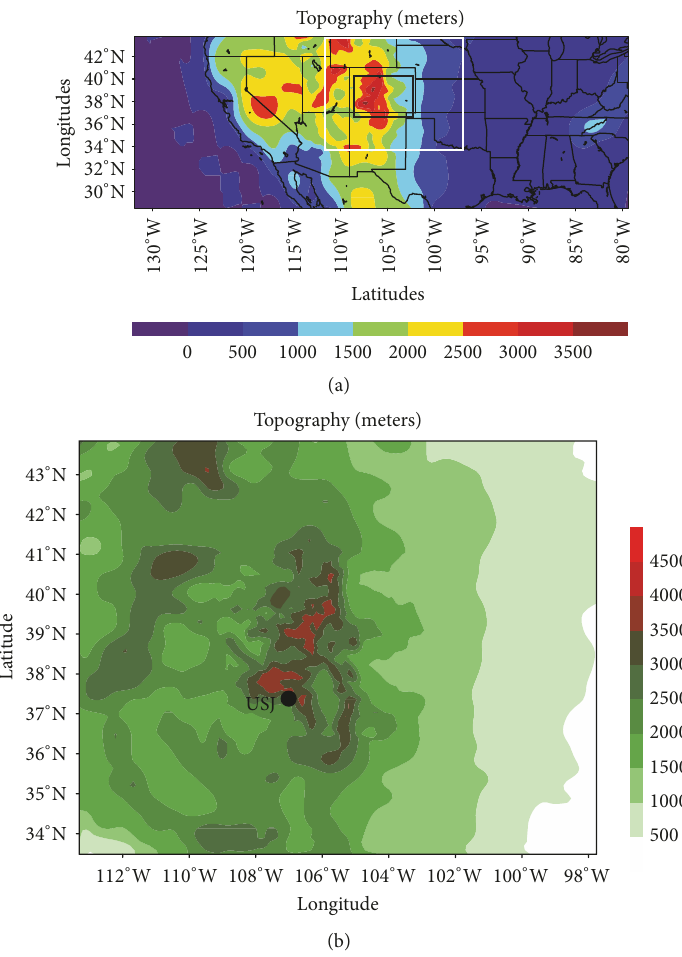
Figure 1: Topography of the area of study where grid 1 is 36 km, grid 2 is 12km shown in white rectangle, and grid 3 is 3 km in black rectangle (a). Topography of grid 3 with USJ (37.49 ∘ N, 106.84 ∘ W) marking the Upper San Juan SNOTEL station